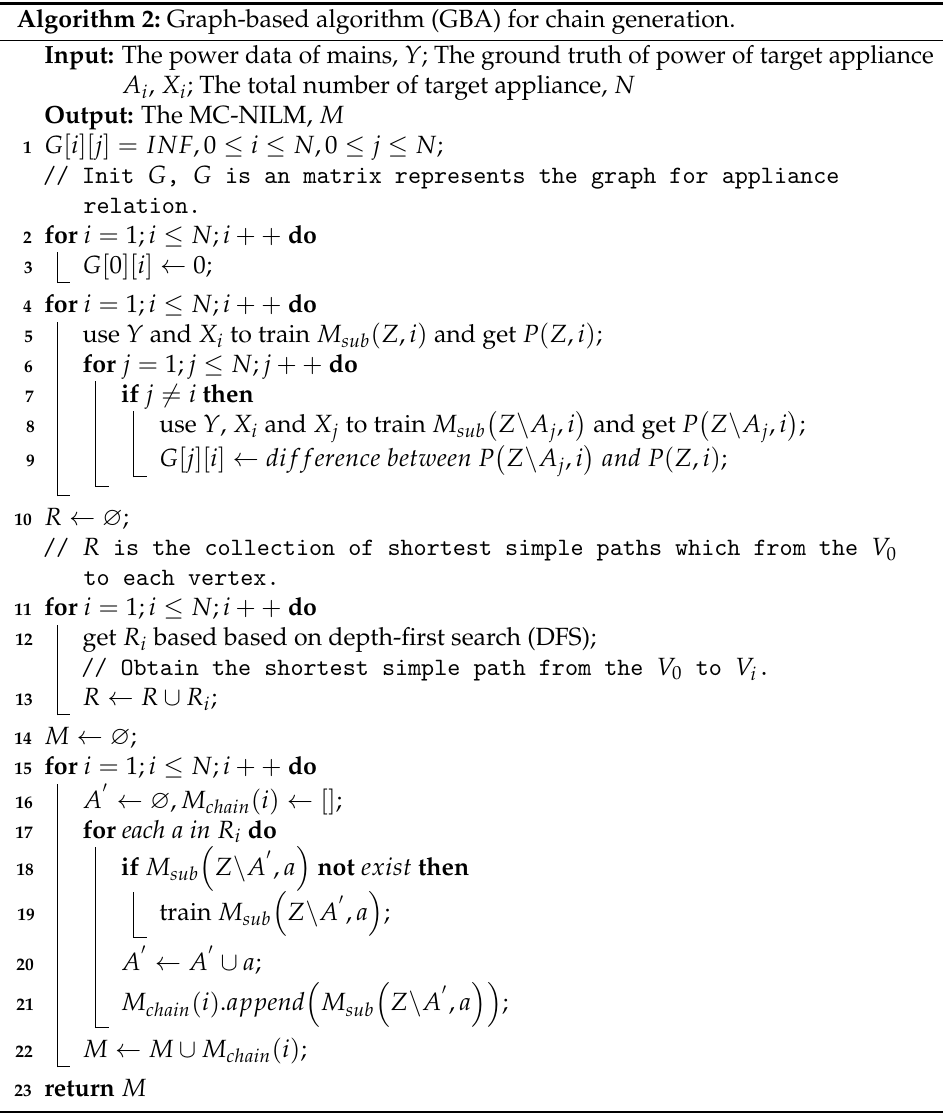
Algorithm 2: Graph-based algorithm (GBA) for chain